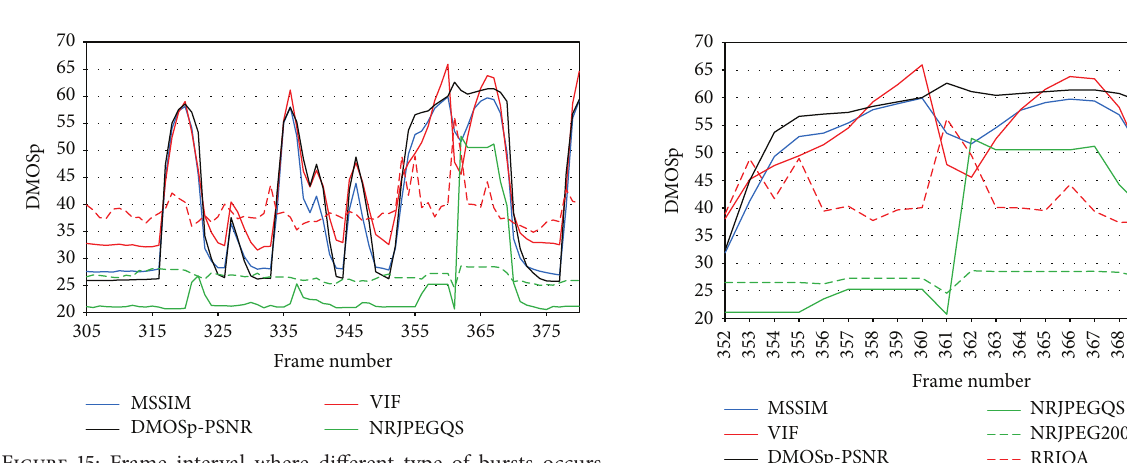
Figure 15: Frame interval where different type of bursts occurs consecutively. Figure 16: Detail from two consecutive long burst with incoming packets between